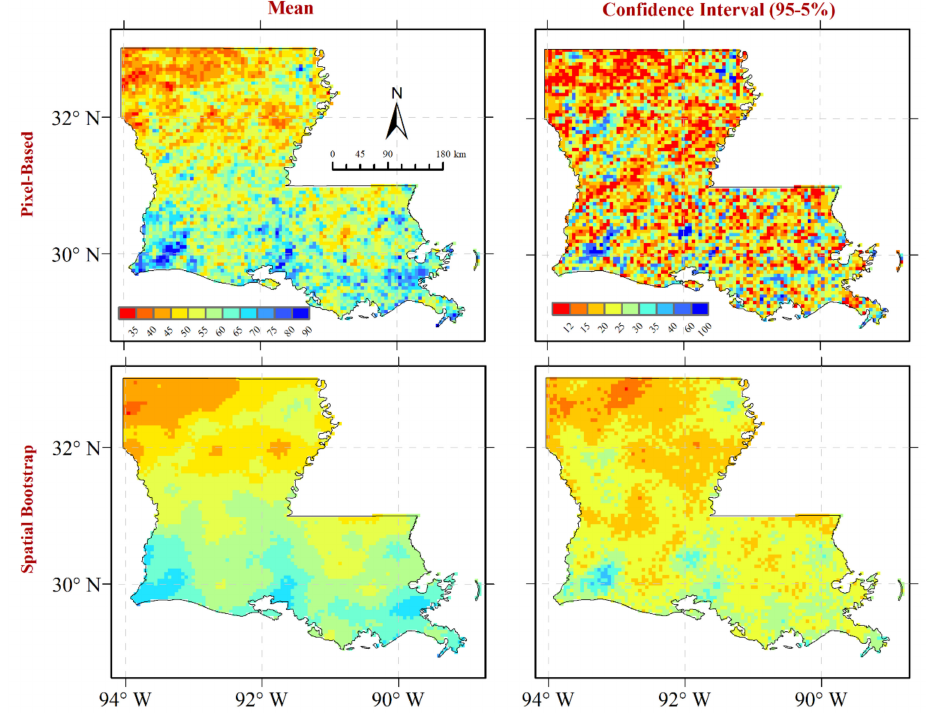
Figure 5. The rainfall depth (in mm) and the confidence width (95–5% percentiles) corresponding to 10-year return period from the pixel-based (upper panels) and spatial bootstrap approaches (region-based) (lower